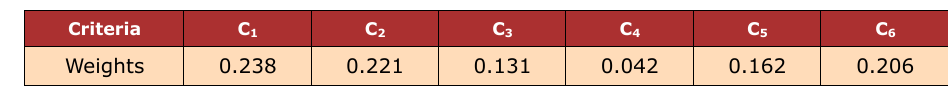
Table 3. Brought amount of weights of criteria